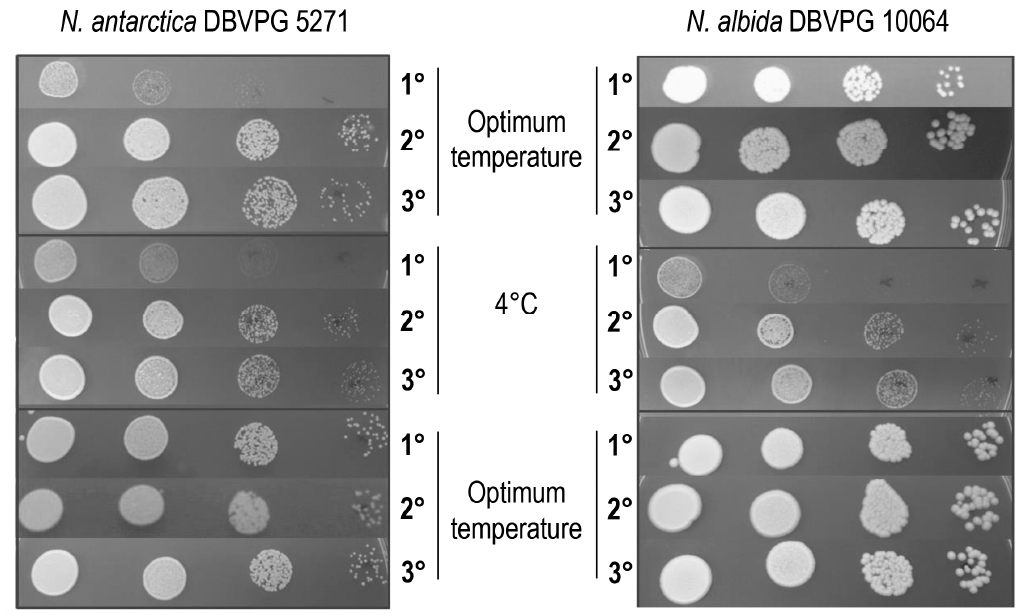
Figure 3. Growth of serial diluted suspensions of N. antarctica DBVPG 5271 and N. albida DBVPG 10064 during the seeding and incubation cycles. Each suspension was inoculated in Petri dishes containing YEPG agar medium as single spot (10 µL).